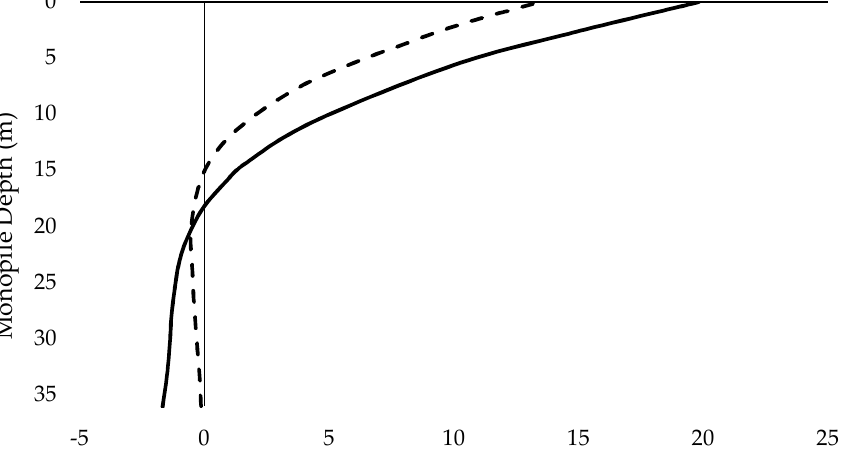
Displacement (mm) Figure 18. Horizontal deflection of the monopile for Pt 0 (solid line) and Fix 0 (dashed line) models.